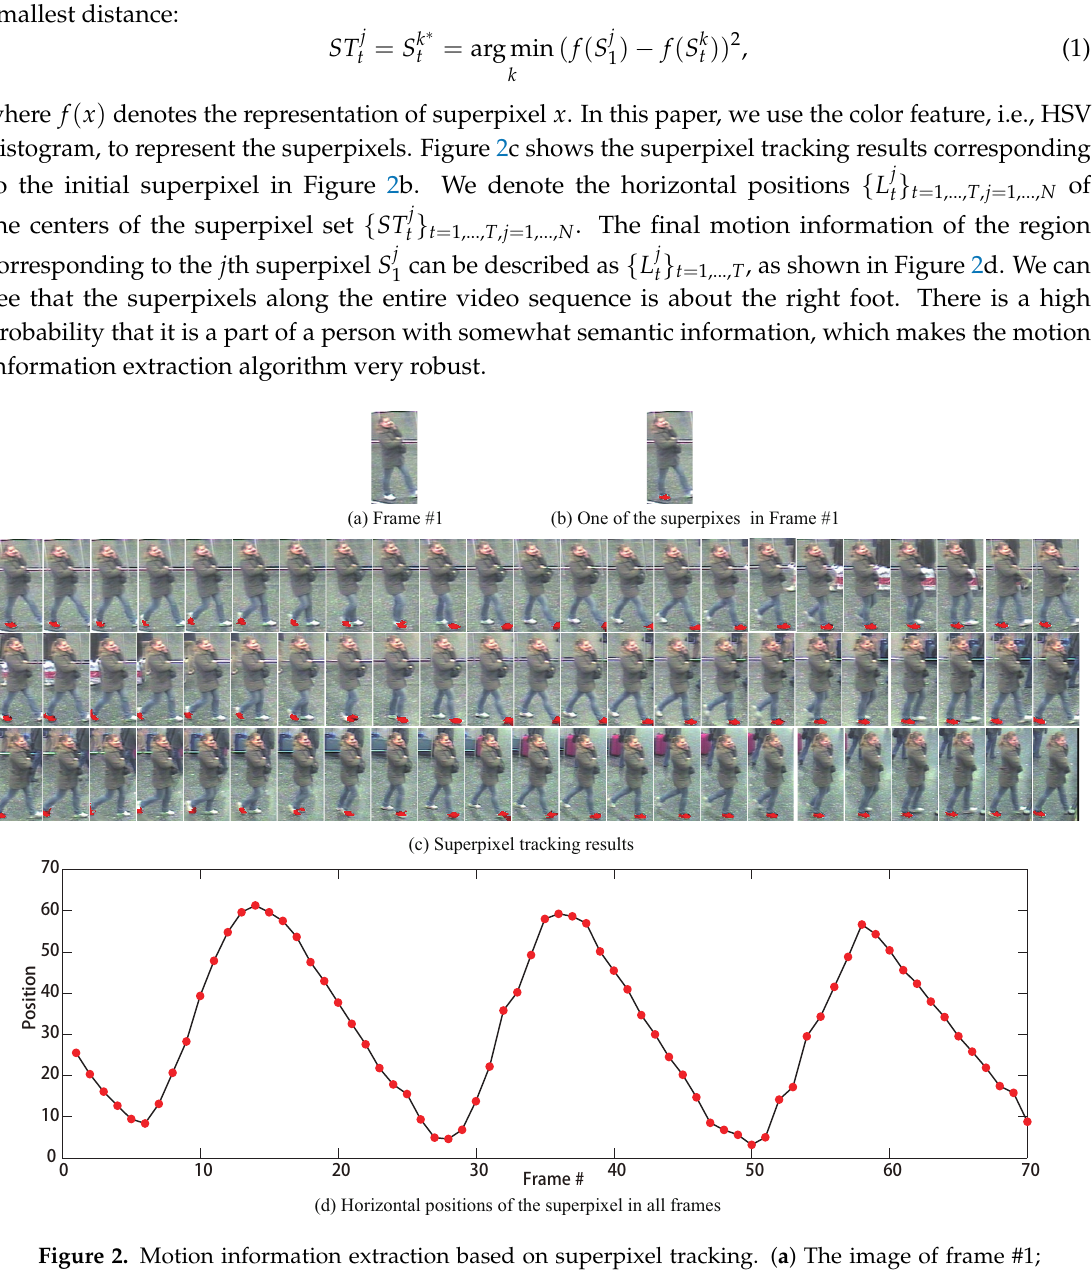
Figure 2. Motion information extraction based on superpixel tracking. ( a ) The image of frame #1; ( b ) One of the superpixels in frame #1, labeled in red color; ( c ) The superpixel tracking results in the images of frame #2 to #70, labeled in red color; ( d ) Horizontal positions (red dots) of the superpixel in all frames. The figure is best viewed in